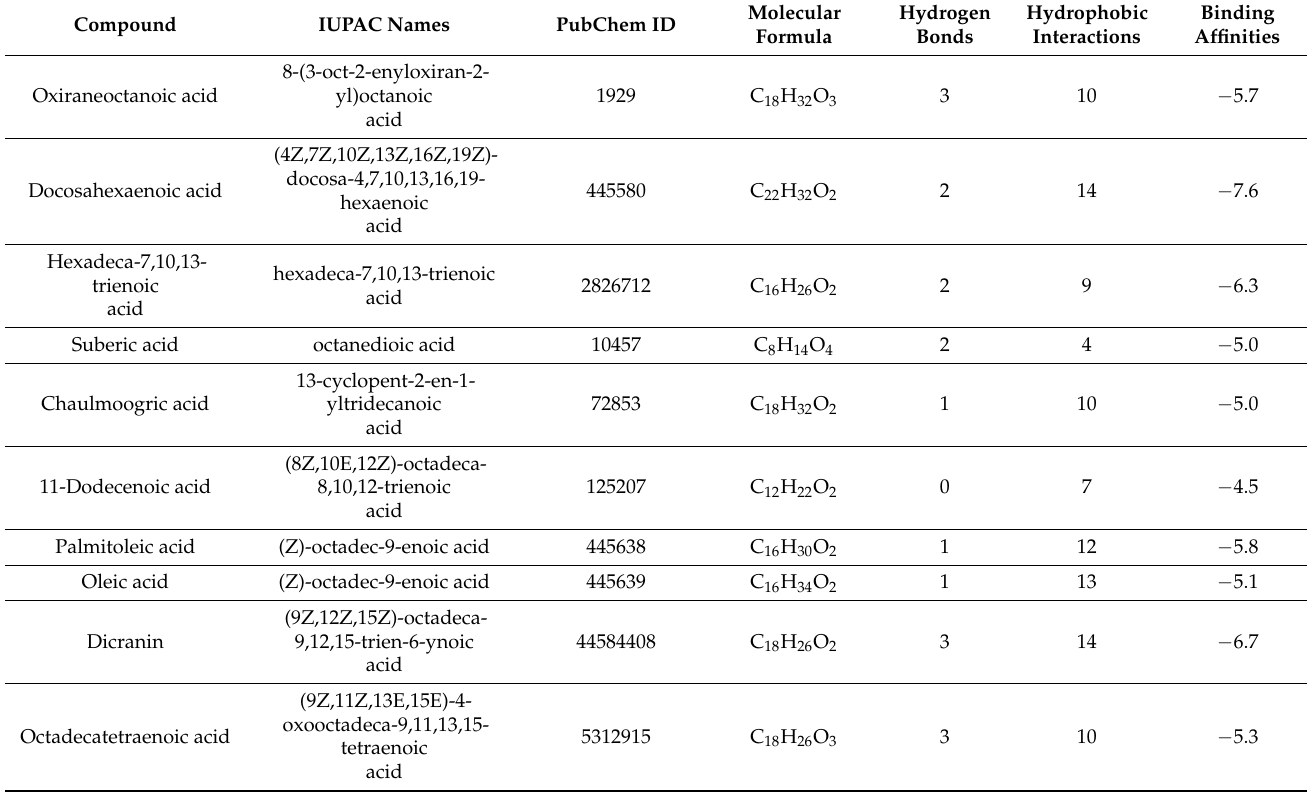
Table 3. The list of top ten compounds showing the lowest binding affinities with B. cinerea lipase. Plant fatty acids with molecular weights and molecular formulas, binding affinites, hydrgen bonds, and hydrophobic interactions are represented in the